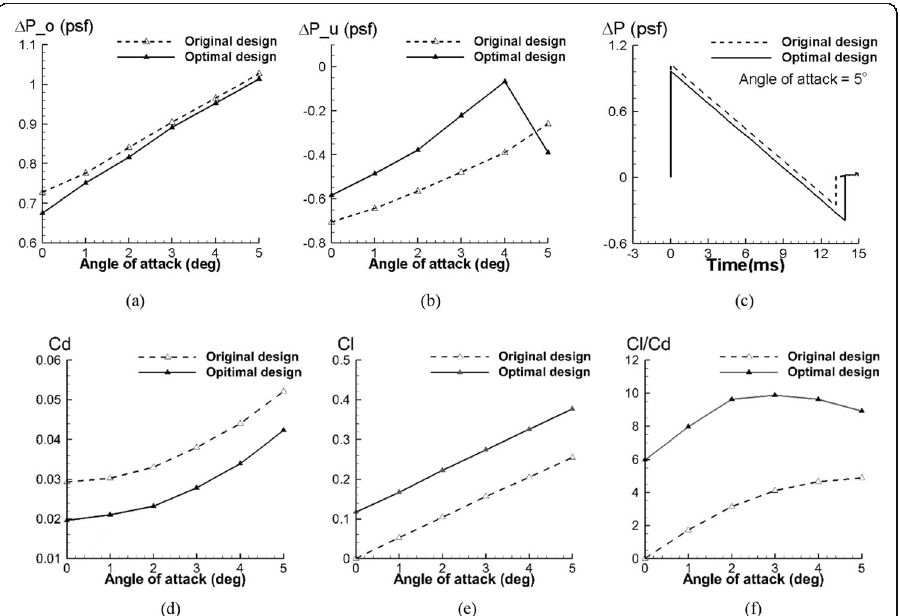
Fig. 18 The ground boom signatures and drag coefficients for the baseline and optimized diamond airfoil with different angles of attack. a the maximum overpressure vs the angle of attack; b the maximum underpressure vs the angle of attack; c comparison of the ground boom signature at the angle of attack = 5 o ; d the drag coefficient vs the angle of attack; e the lift coefficient vs the angle of attack; f the lift-drag ratio vs the angle of